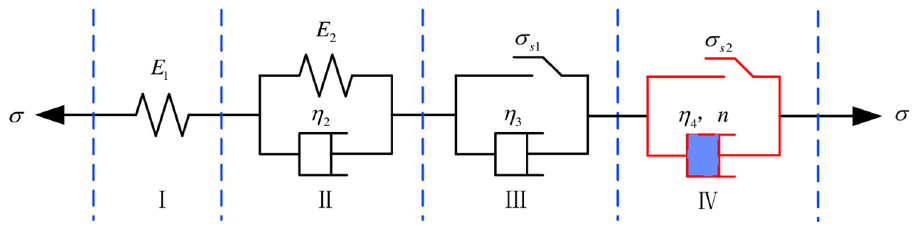
Fig 2. Improved Nishihara model considering accelerated creep